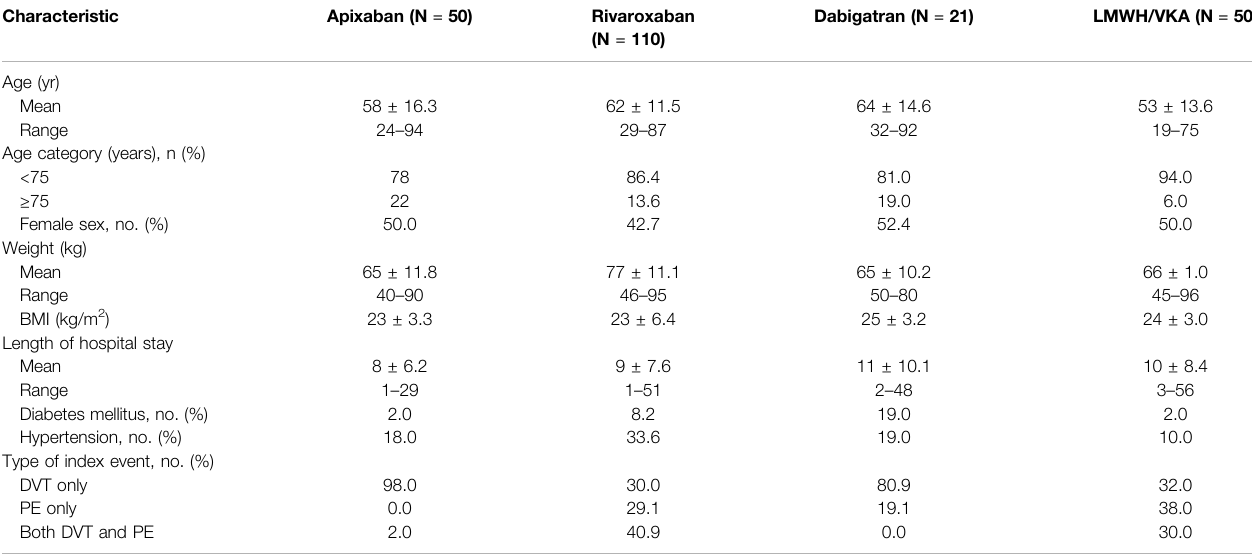
TABLE 2 | Comparison of the baseline characteristics of the four groups. Characteristic